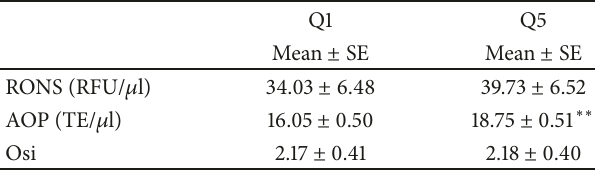
Table 3: Systemic oxidative stress indices.